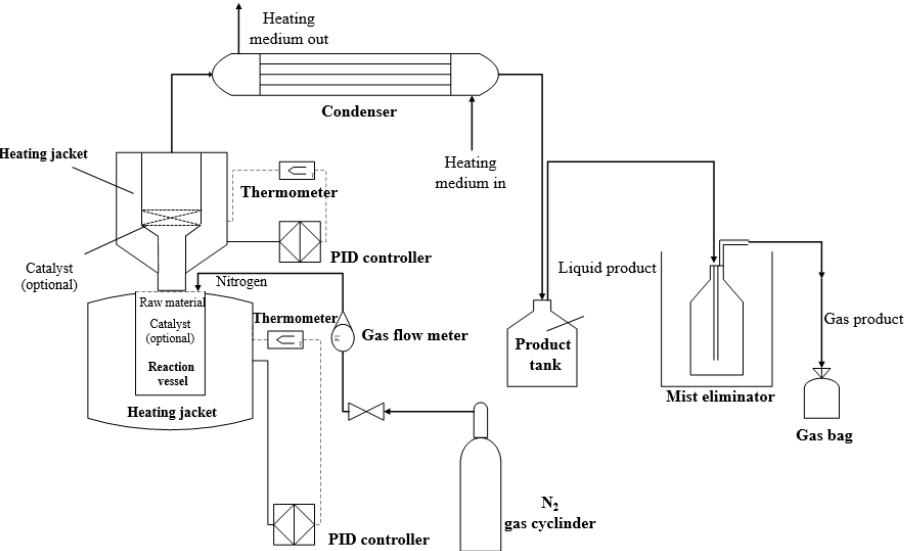
Figure 1. The scheme of the experimental equipment.